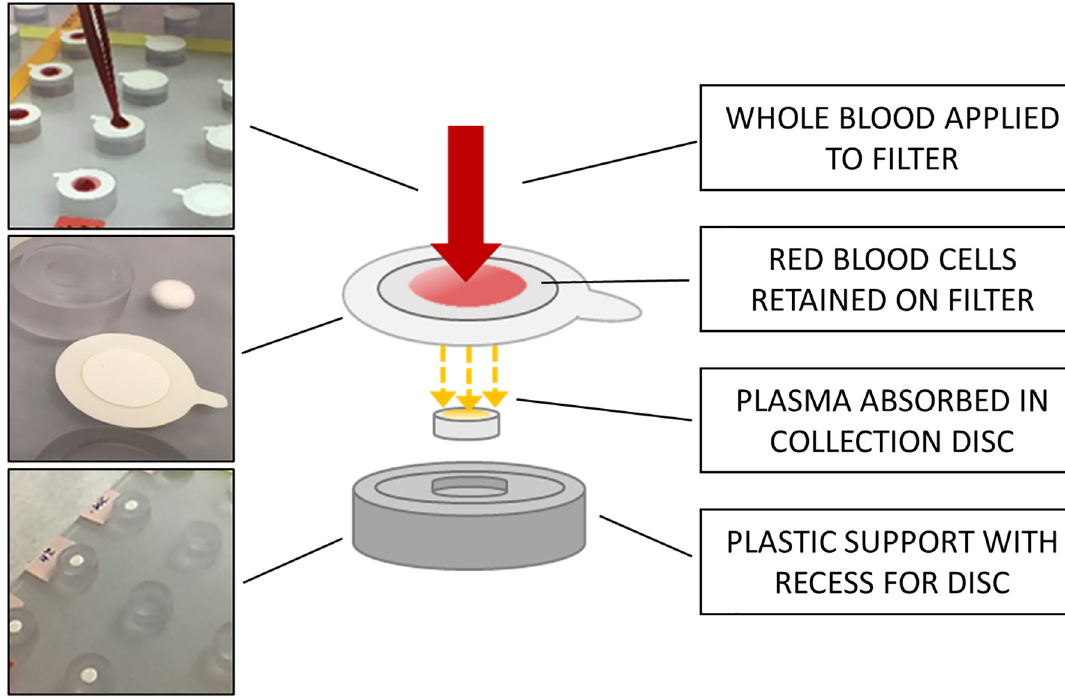
Fig 2. Schematic illustrating the plasma collection disc in operation. The schematic illustrates a single PCD. Photos on the left show the PCD with the the filter disc placed on a manifold for multiple samples and the addition of 35 μ L of whole blood to each disc (top), a PDC detail view prior to whole blood being added (middle), and the discs after blood has been absorbed and finally the plasma collection disc exposed after the whole blood treated filter has been removed (bottom). The disc is removed with sterile forceps and is ready for use or can be stored until